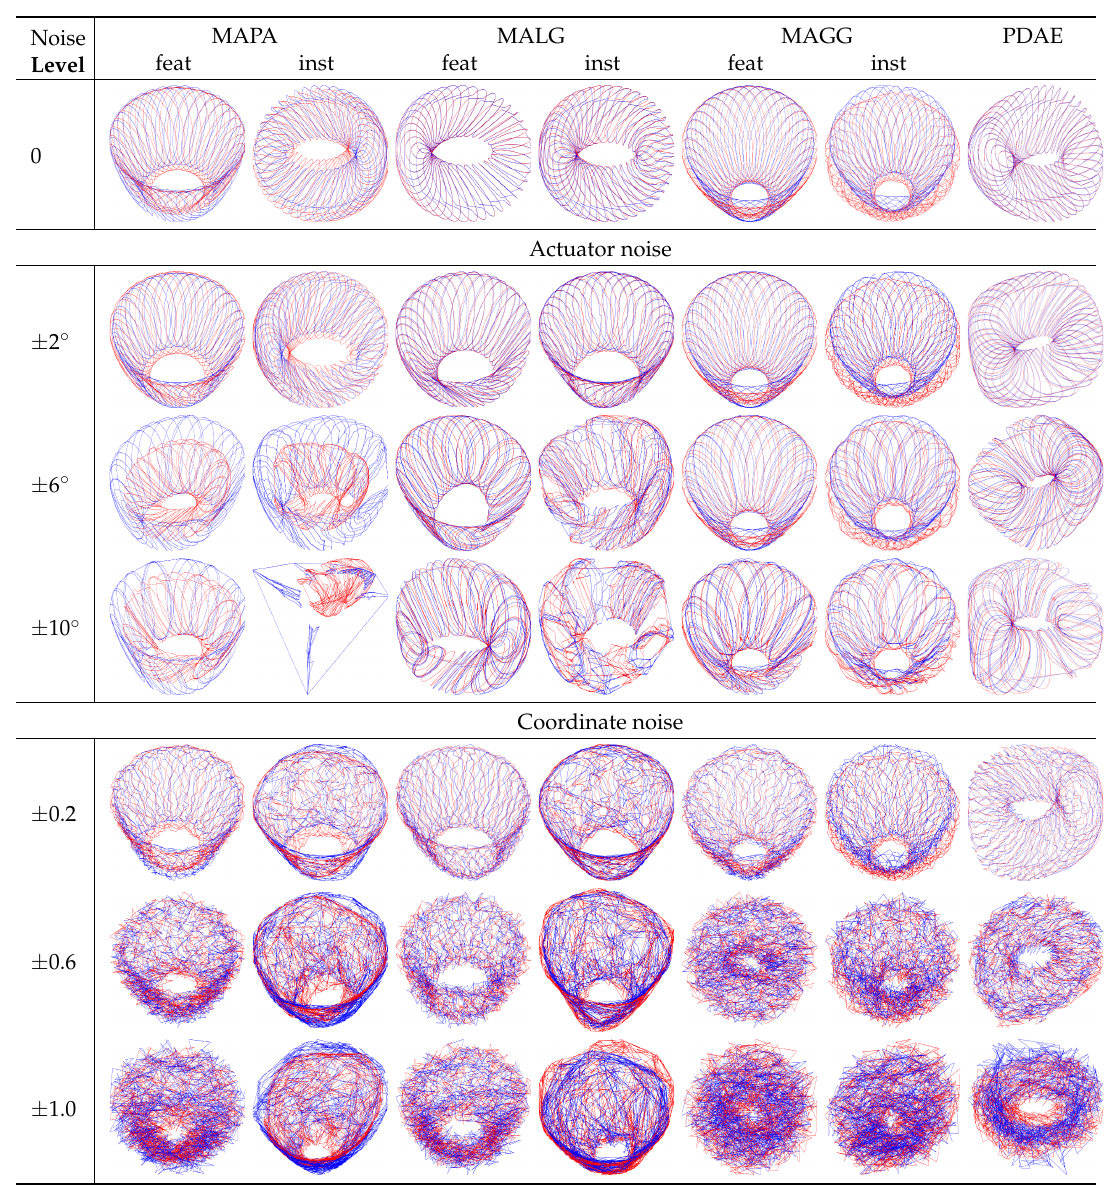
Figure 5. Manifold alignments of 2D motion data under the influence of noise: The graphs visualise the outcomes of aligning datasets X (red) and Y (blue) using the seven methods mentioned at the top. Each row shows the results obtained under the influence of a different level of actuator noise (Rows 2–4) and coordinate noise (Rows 5–7). The expected result is a torus S 1 × S 1 . However, the outcomes of MAPA, MALG and MAGG tend to collapse into a cylinder or for noise ranges ≥± 2 ◦ misalign or otherwise disintegrate, particularly at the instance level. The only exception seems to be MALG-feat at the highest level of actuator noise. Otherwise, the graphs in the rightmost column demonstrate that of all methods tested, PDAE has the best ability to produce the expected torus-like manifold at all levels of